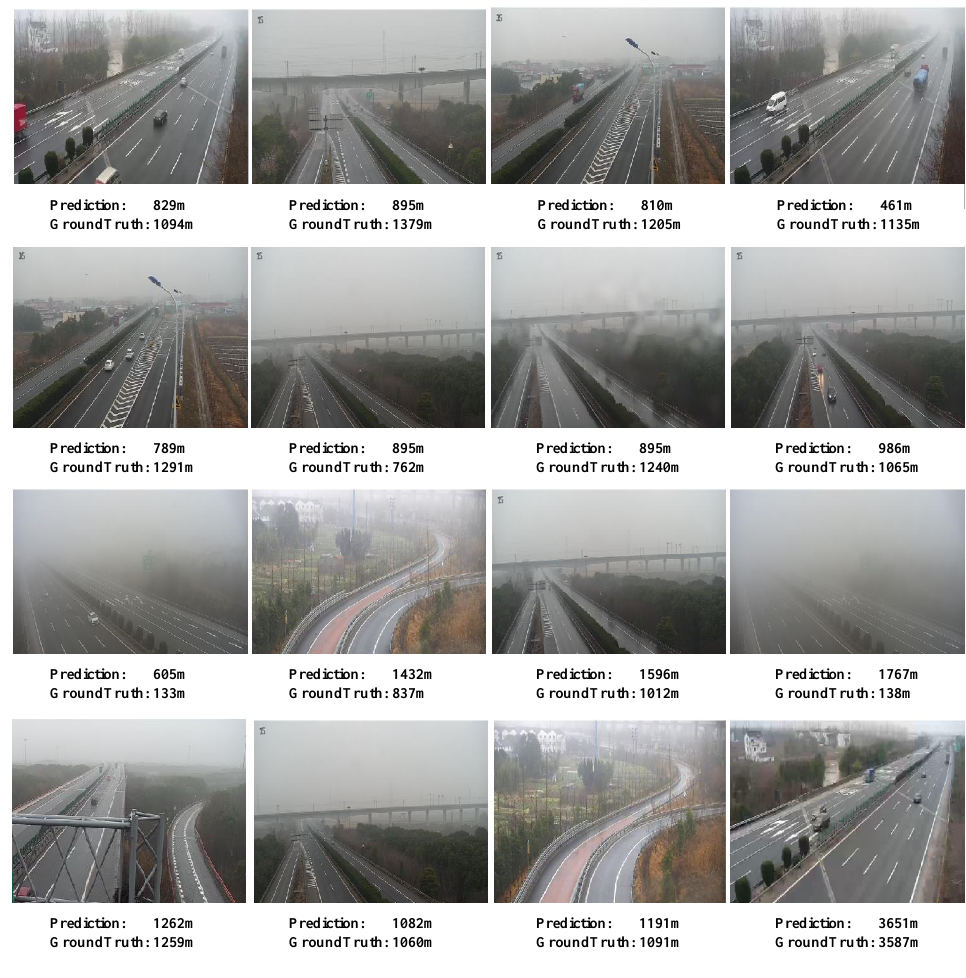
Figure 4. Quantified visibility estimation of DQVENet.